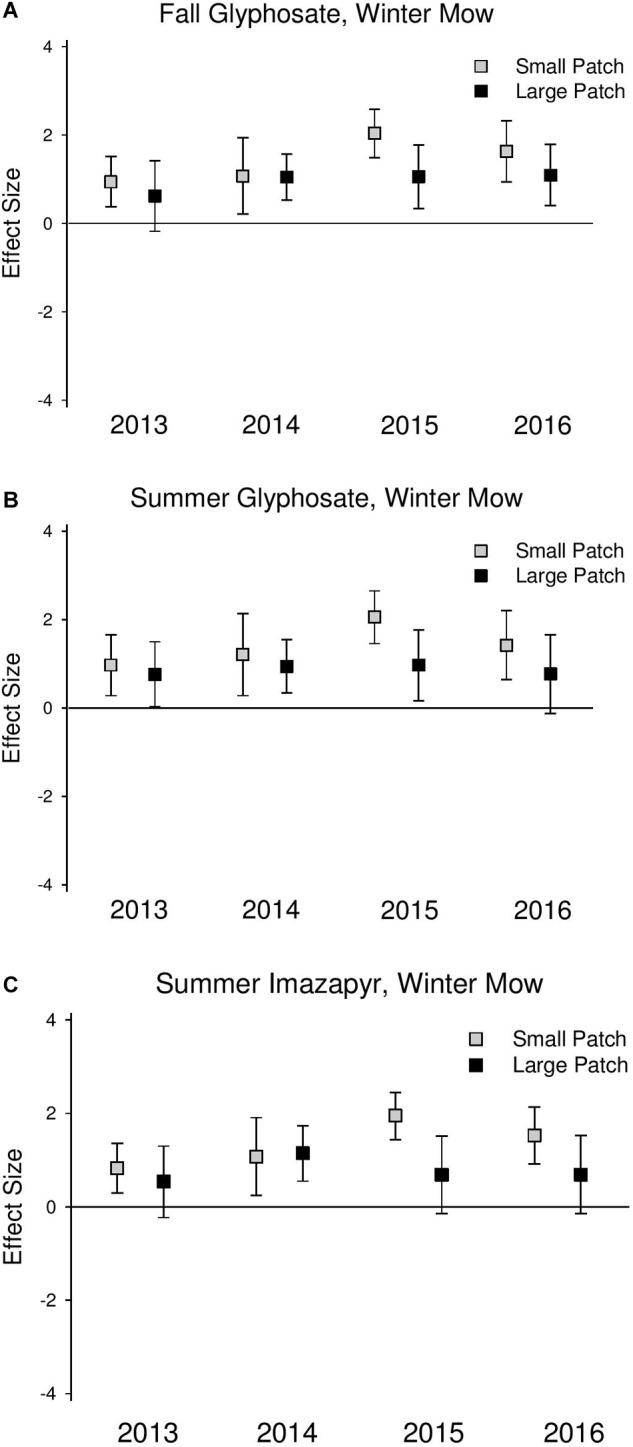
Effect size graphs for species richness for three herbicide treatments [(A) fall glyphosate, winter mow, (B) summer glyphosate, winter mow, and (C) summer imazapyr, winter mow]. Points are effect sizes at each scale, in each year, bounded by the upper and lower limits of the 95% confidence interval.